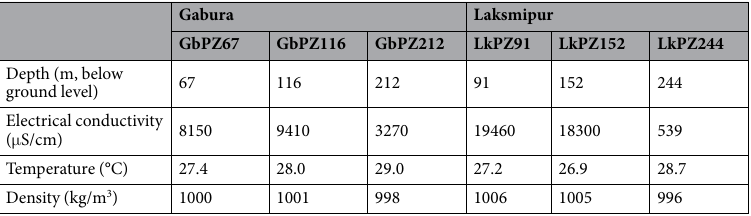
Table 3. Screen depths and groundwater electrical conductivity, temperature, and density for the boreholes at Gabura and Laksmipur, southern Bangladesh; borehole names include numbers which indicate the screen depth in metres, at which the head determinations